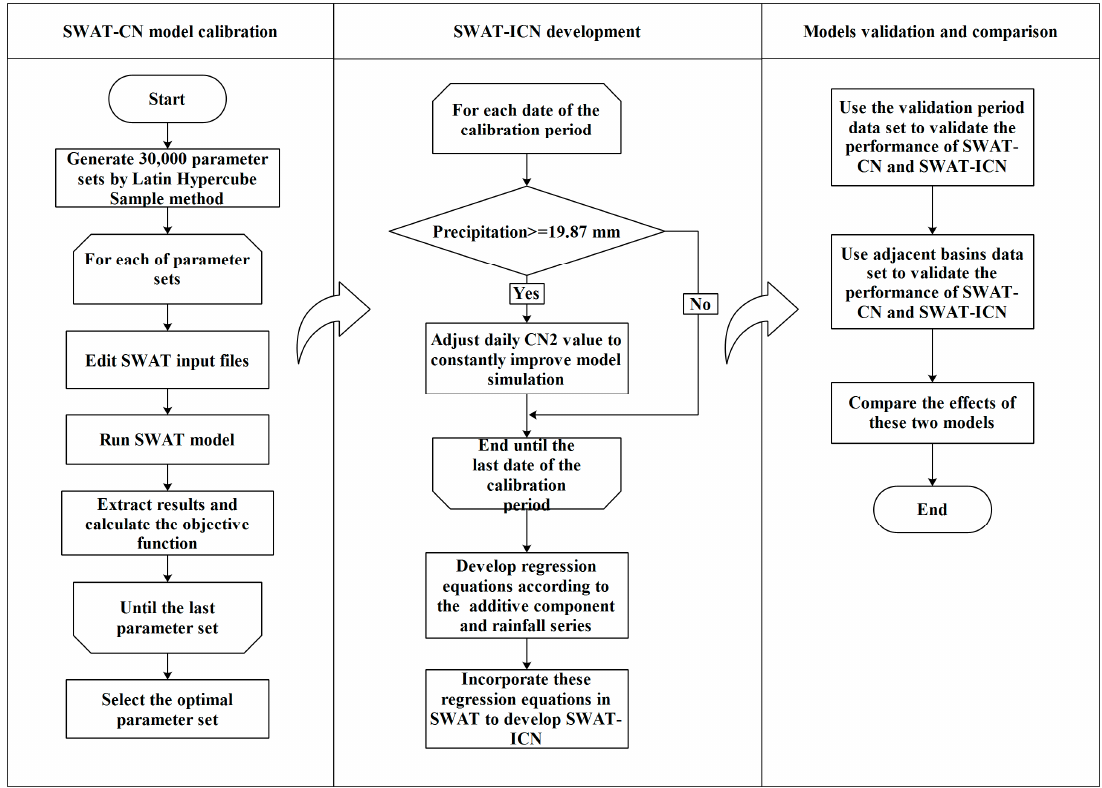
Figure 2. Flow diagram of the calibration, development and validation process of SWAT-CN and SWAT-ICN.